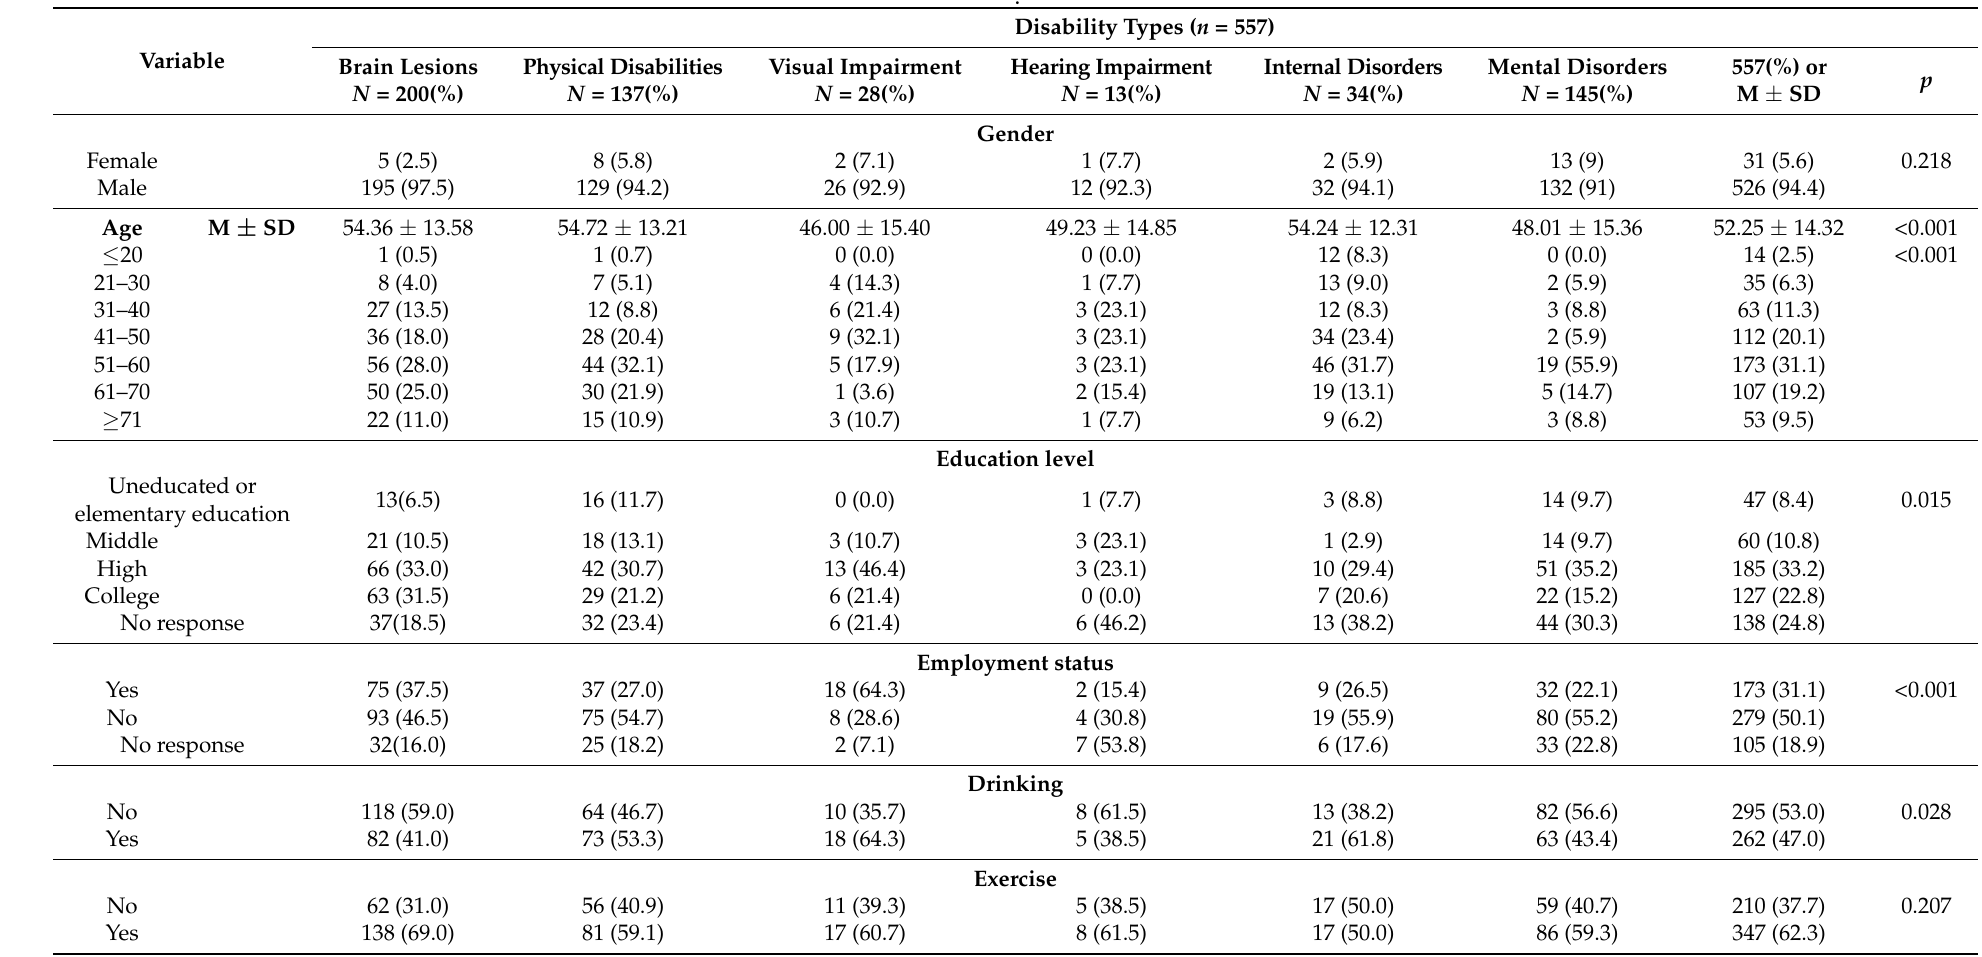
Table 1. General characteristics according to disability